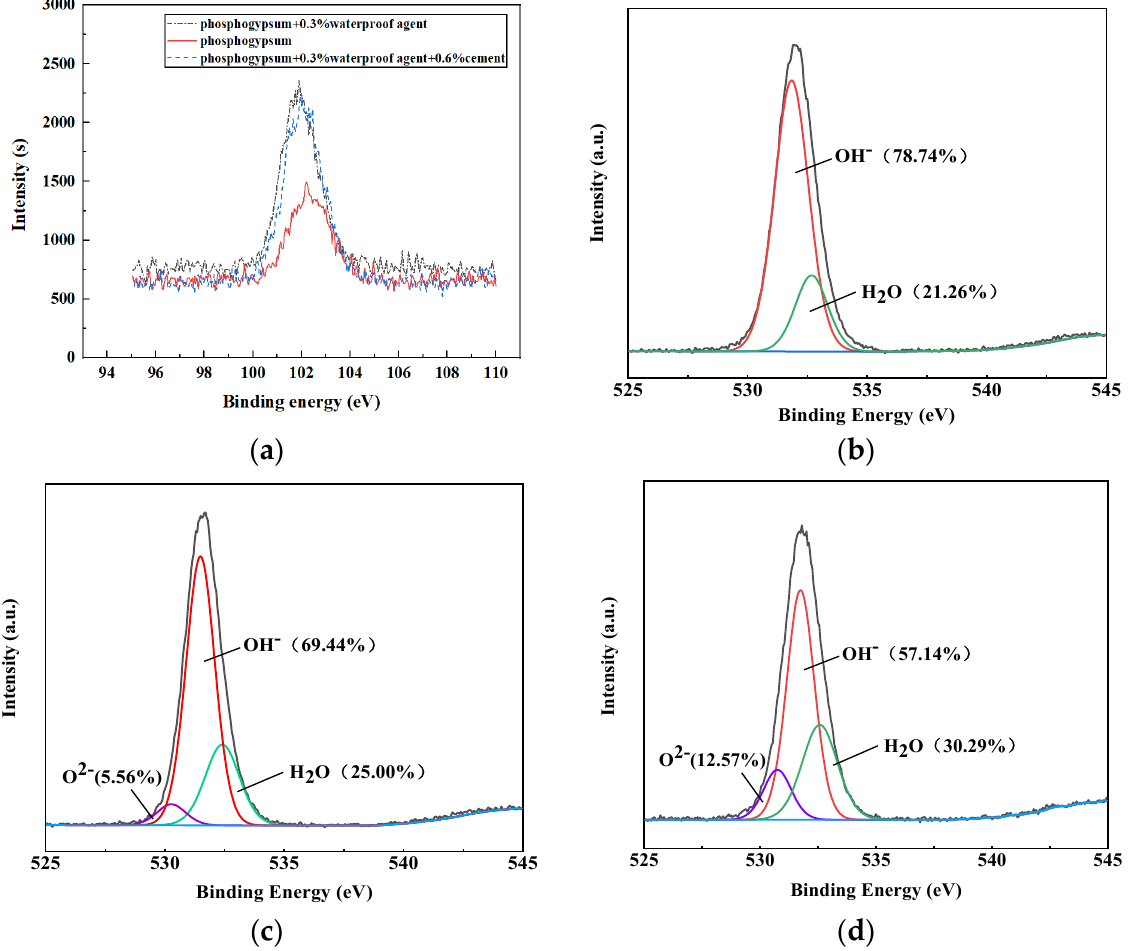
Figure 6. XPS spectra of Si 2p and O 1s in the gypsum sample. ( a ) Change in Si 2p in gypsum samples. ( b ) Phosphogypsum reference group O 1s. ( c ) Phosphogypsum +0.3 wt.% of hydrophobic agent. ( d ) Phosphogypsum +0.3 wt.% hydrophobic agent +0.6 wt.% cement.